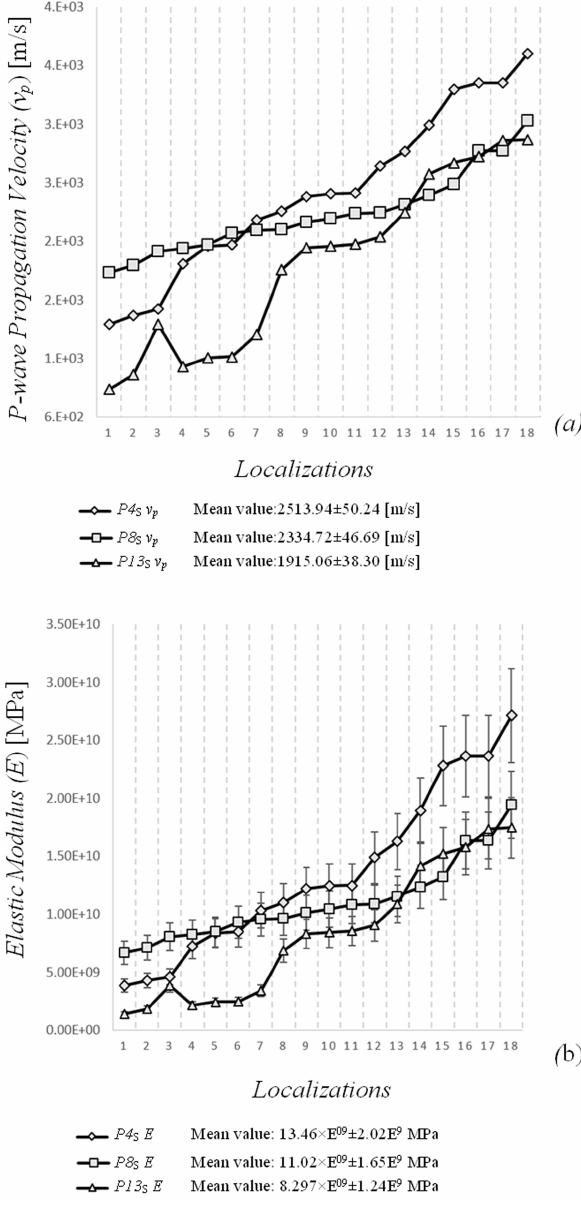
Figure 8: P-wave propagation velocities obtained by 54 localiza- tions on the three slanted pillar P4S, P8S, P13S. The values were reordered considering increasing values for each series (a). P4